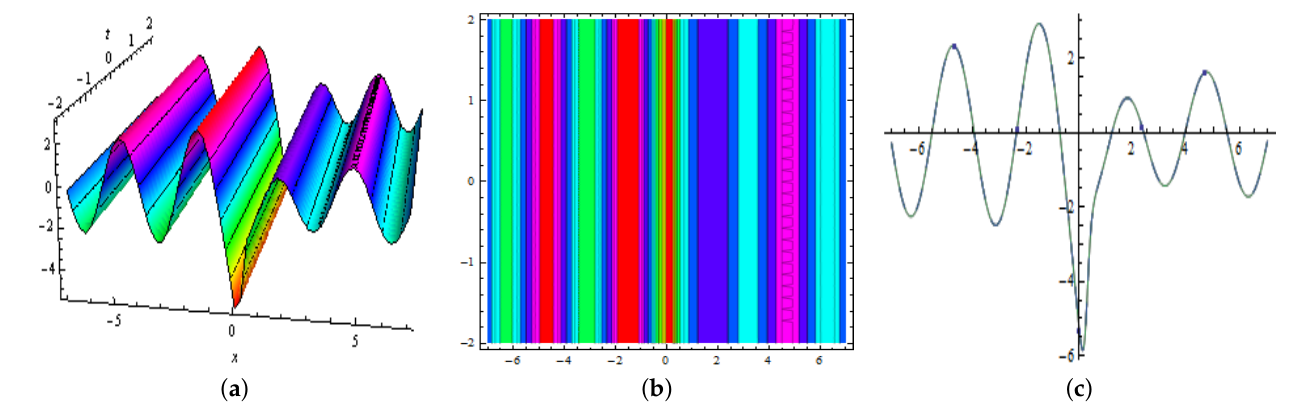
Figure 1. Plots of m 23 ( x , t ) in Equation (17) for a = 2, b = 1.2, u 0 = − 2, b 2 = 3, b 3 = 5, b 4 = − 3, α = 0.9, respectively as three-dimensions in ( a ); contour in ( b ) and two-dimensions in ( c ) Set III. For u 0 = 0,